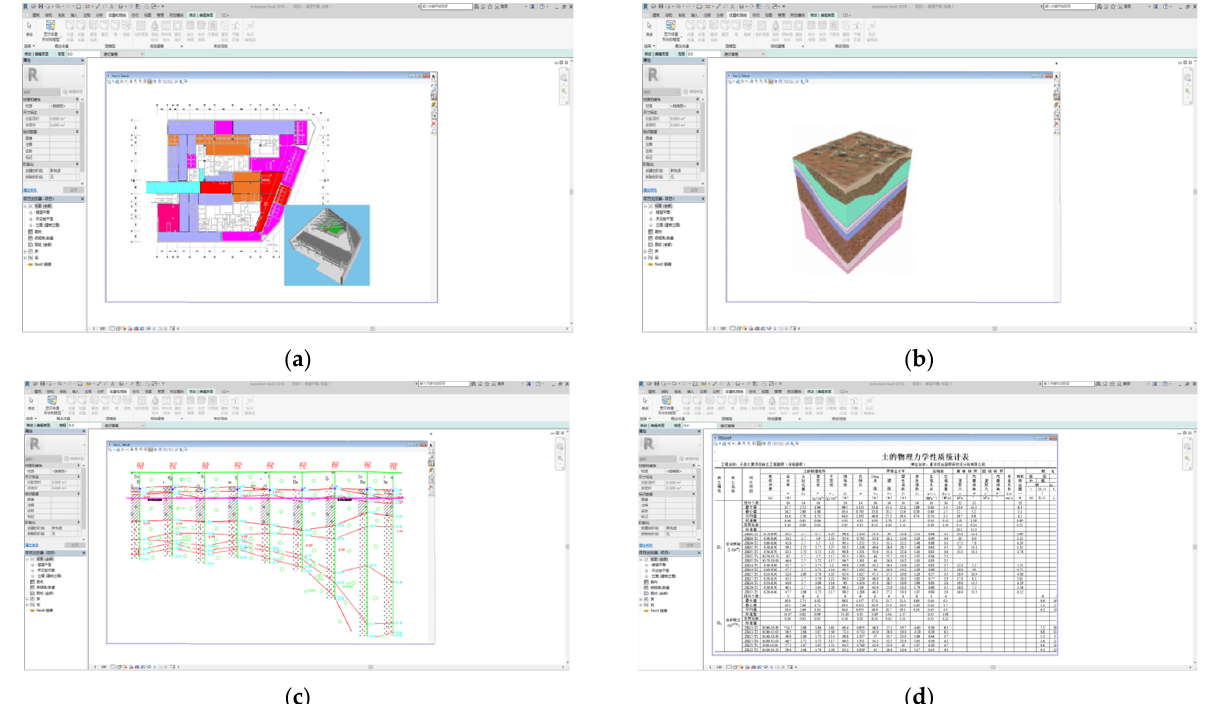
Figure 5. Models developed for the case study: ( a ) creates a BIM 3D model; ( b ) an integrated BIM model (architectural, Shapes, dimensions, and materials) with GIS through IFC; ( c ) the invocation of a geological report in the BIM model; and ( d ) the invocation of soil properties uploaded in a BIM model.